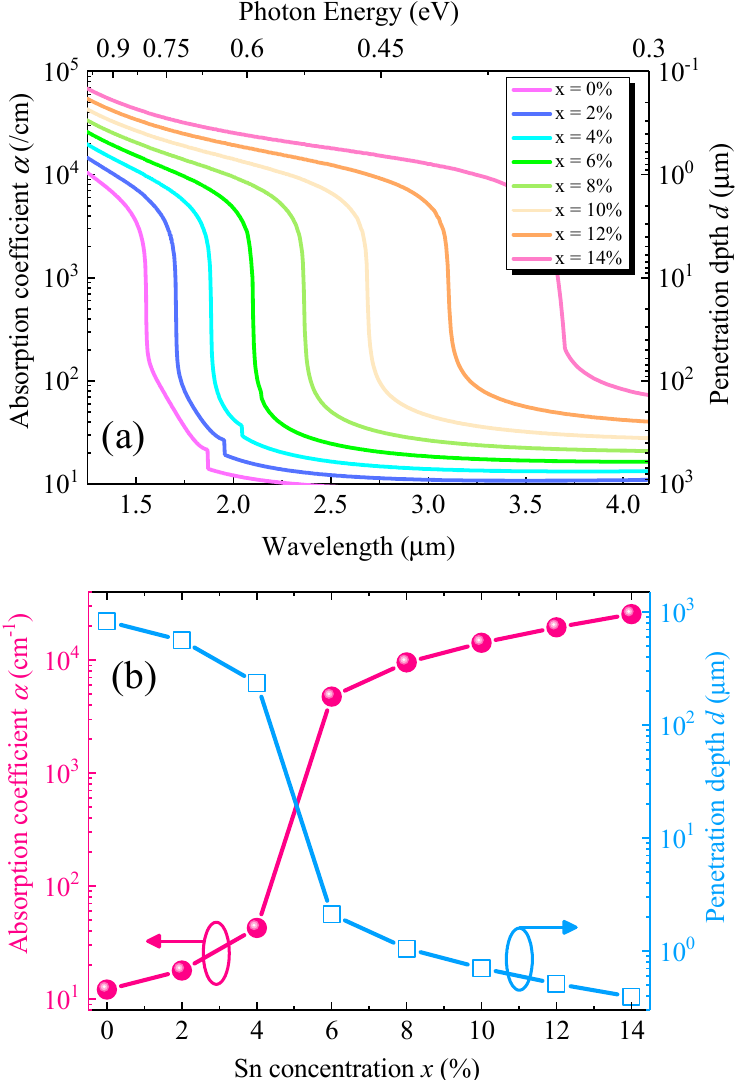
Figure 2. ( a ) Calculated total absorption coefficient and penetration depth spectra of GeSn WGPD for different Sn concentrations. ( b ) Calculated total absorption coefficient and penetration depth with various Sn concentrations at λ = 2 µm.